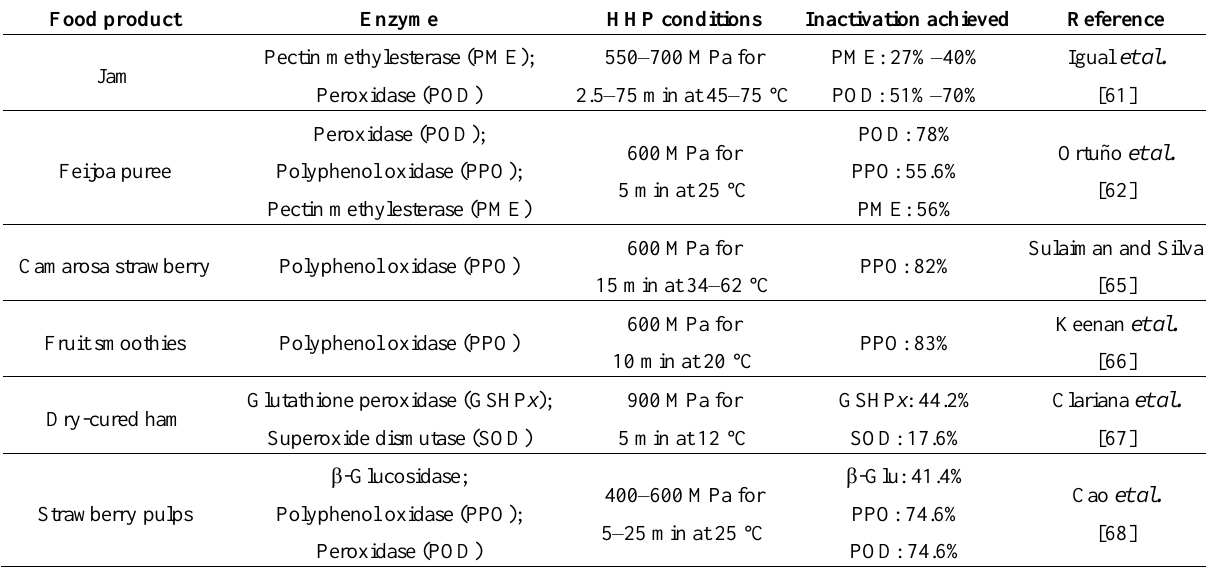
Table 4. HHP inactivation of enzymes in different